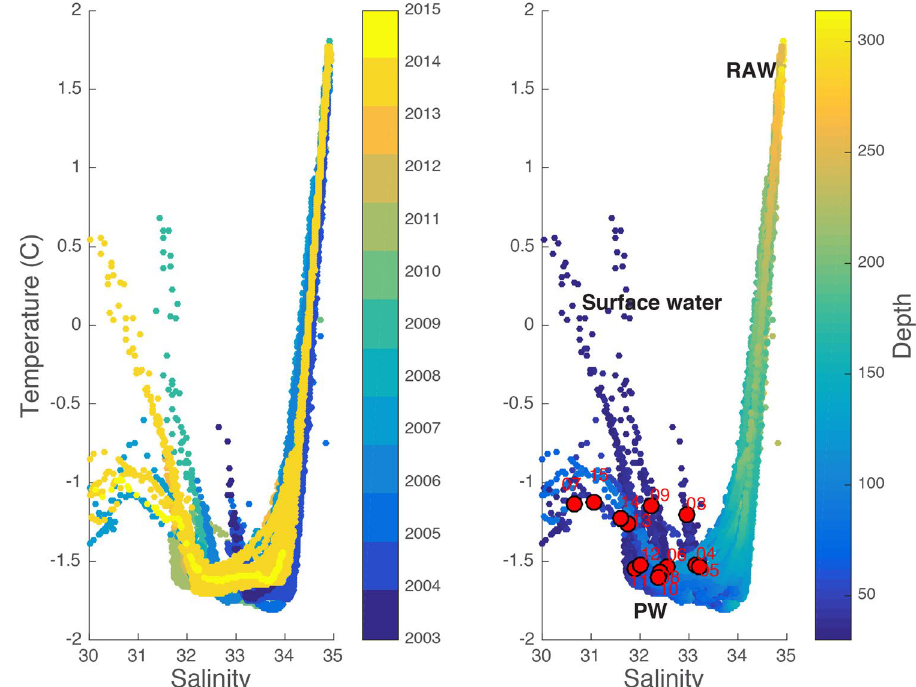
Figure 4. Temperature-Salinity plots of the subsurface ( > 30 m) coastal waters outside Young Sound in East Greenland. ( a ) The symbols are coloured by year and ( b ) by depth. PW: Polar water (T < 0, S < 34.4); RAW: Recirculating Atlantic Water (T > 0, S > 34.4). Superimposed on ( b ) are the average salinity and temperature values for coastal waters, at 30–50 m. (red dots, labelled with